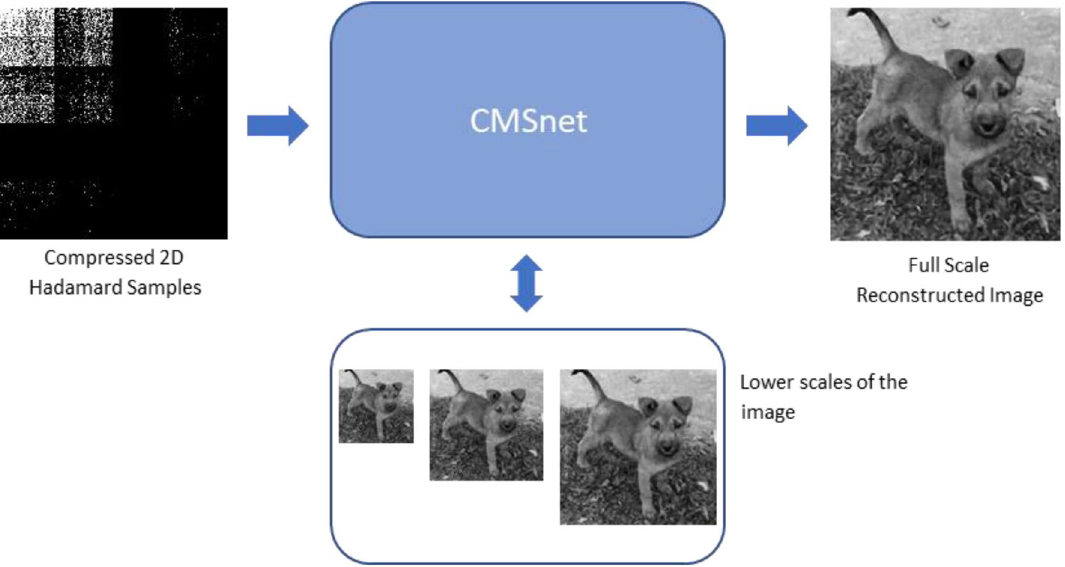
Figure 8. Proposed multiscale compressive sensing reconstruction scheme. The method utilizes the multiscale information that was gathered during the sampling process to improve the reconstruction quality of the